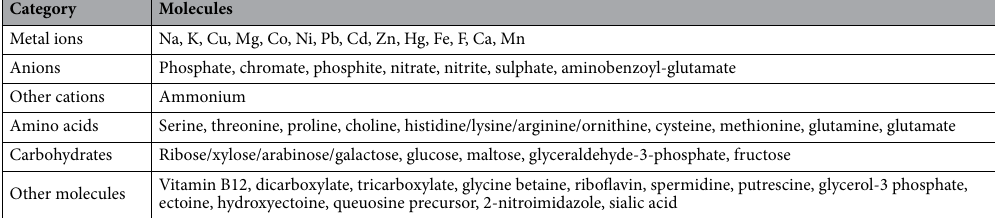
Table 3. Transporter systems for transfer of molecules identified in the H. malpeensis YU-PRIM-29 T genome .